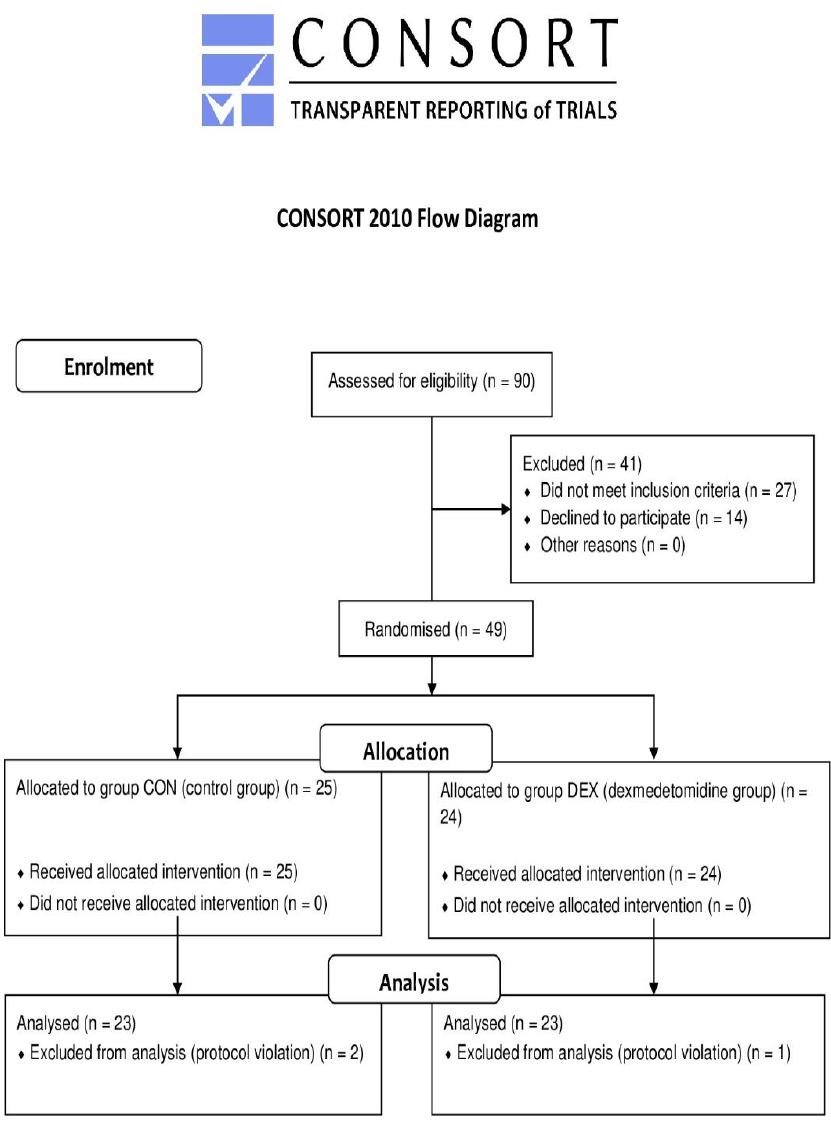
Figure 1. Flow chart of patient selection.